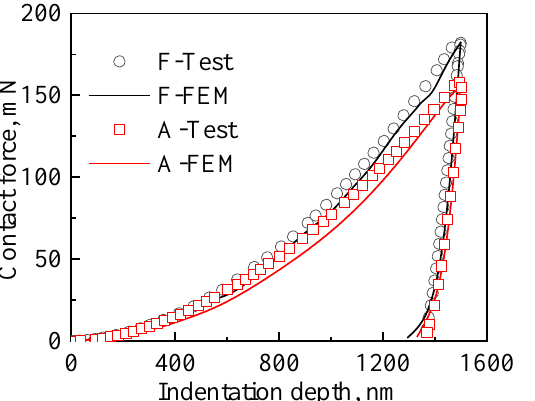
Figure 9. Tensile curves of austenite and ferrite phases.